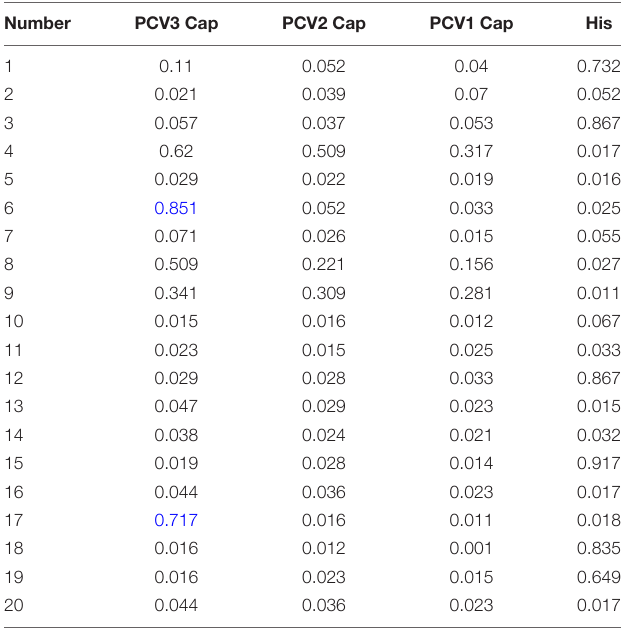
TABLE 2 | Screening results of ELISA for positive hybridoma cells.